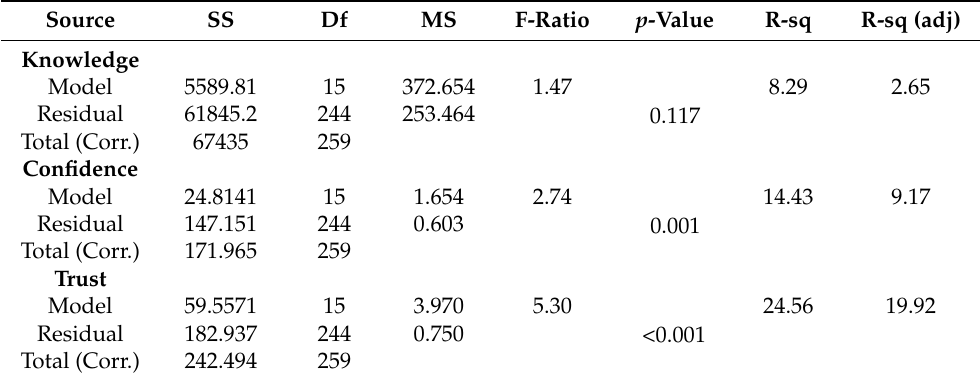
Table 4. Variable influence of the knowledge score, confidence, and trust.